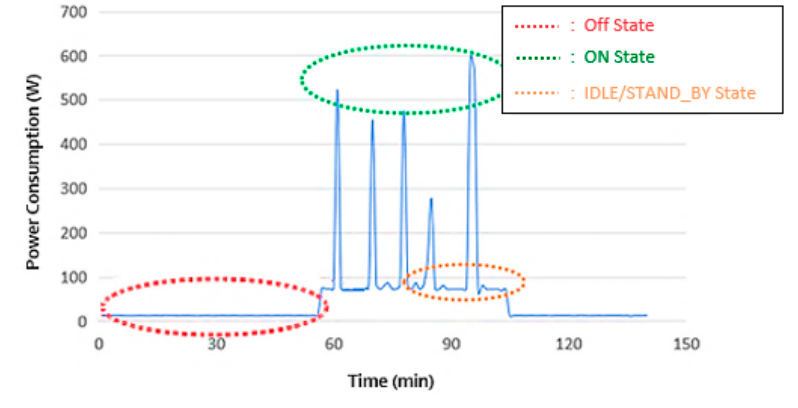
Figure 7. Printer consumption profile.